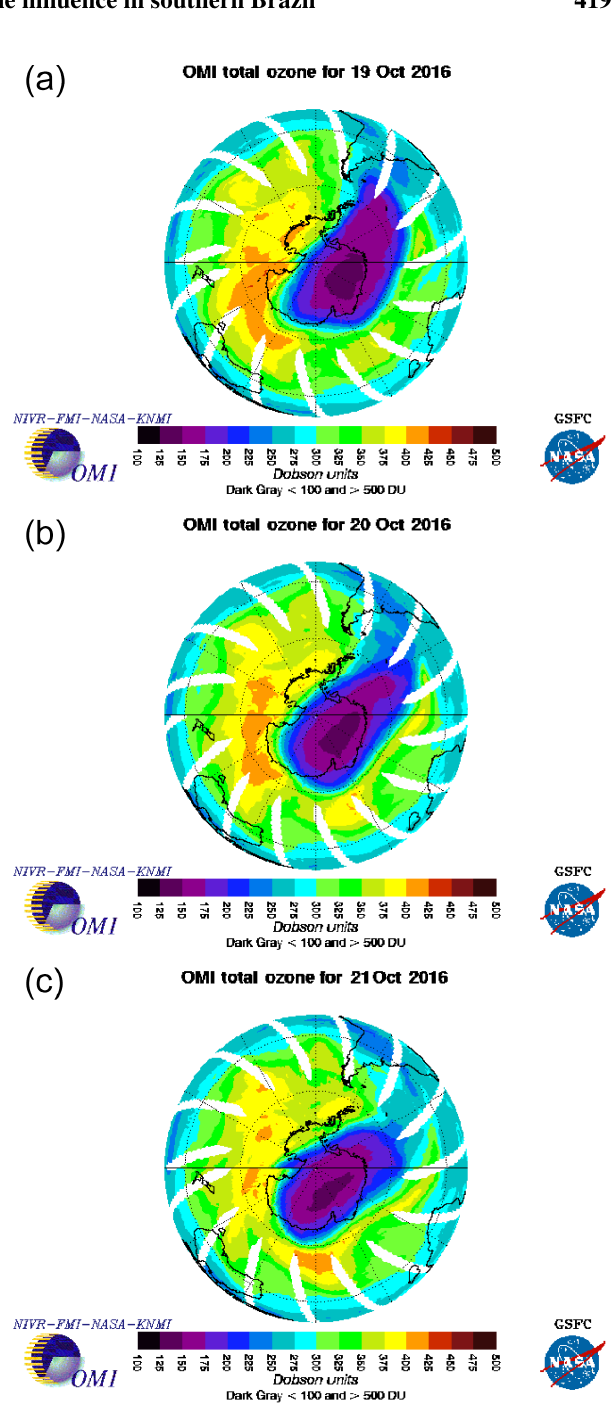
Figure 4. Image of the OMI satellite showing the influence of the ozone hole for southern